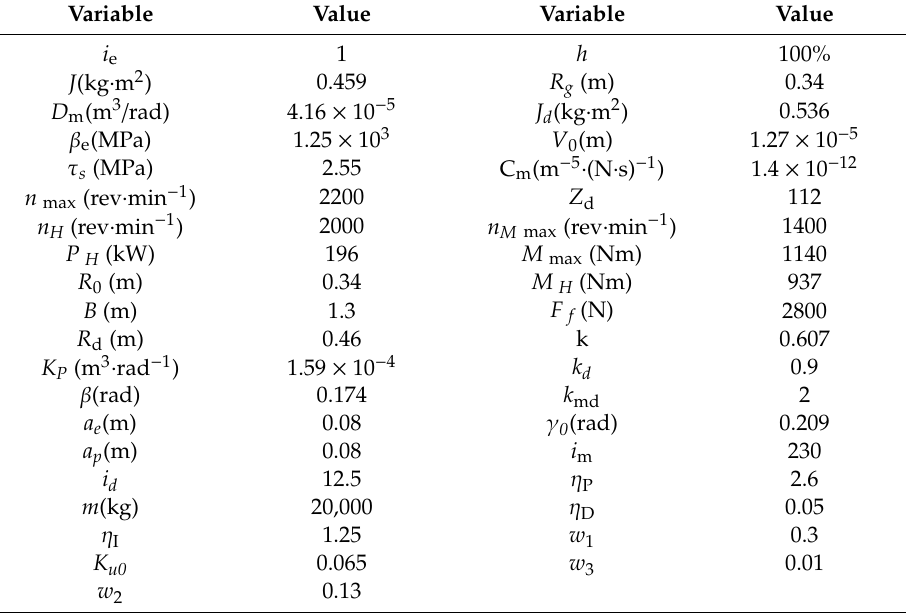
Table 1. Parameters confirmation in the